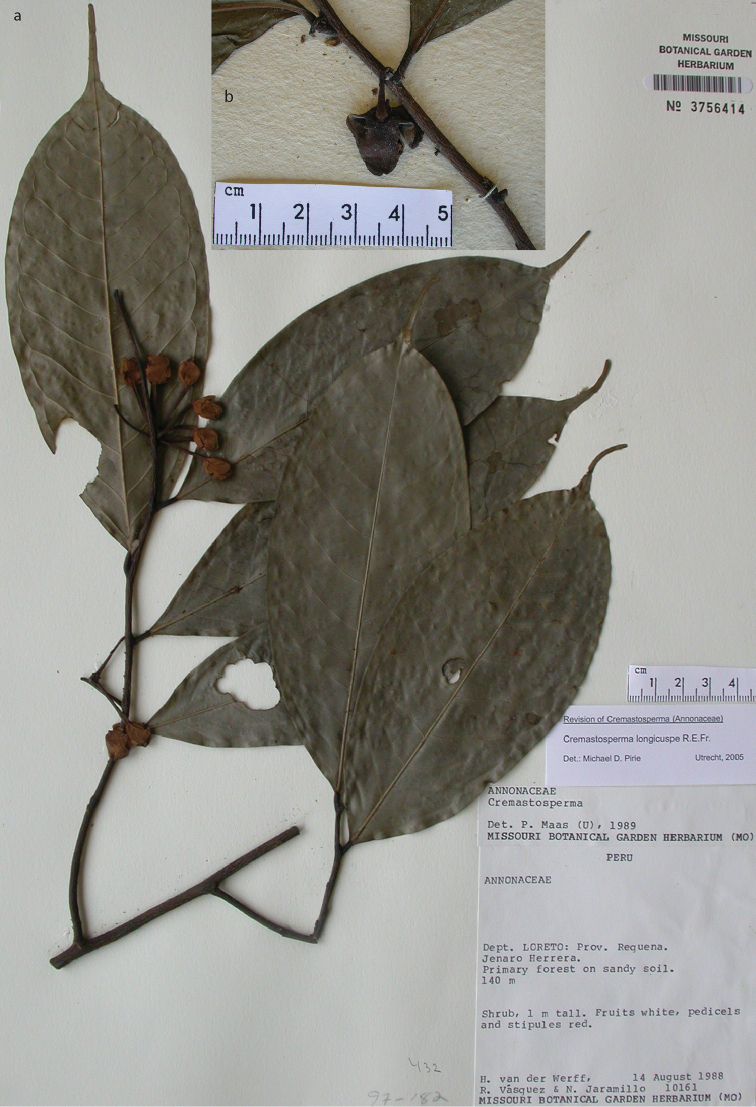
Cremastospermalongicuspe R.E.Fr. a fruiting specimen b flower (avan der Werff 10161bPoeppig s.n.).